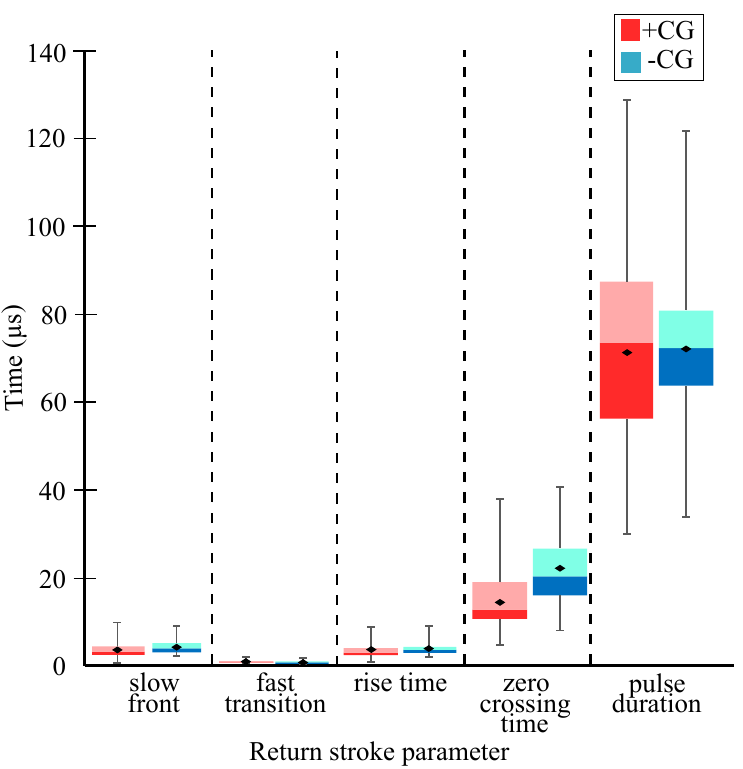
Figure 5. Statistics of overall return strokes parameters including slow front, 10–90% fast rising, 10–90% rise time, zero crossing time, and pulse duration in µs scale. Red box represents +CG, while blue/cyan box represents − CG flashes.